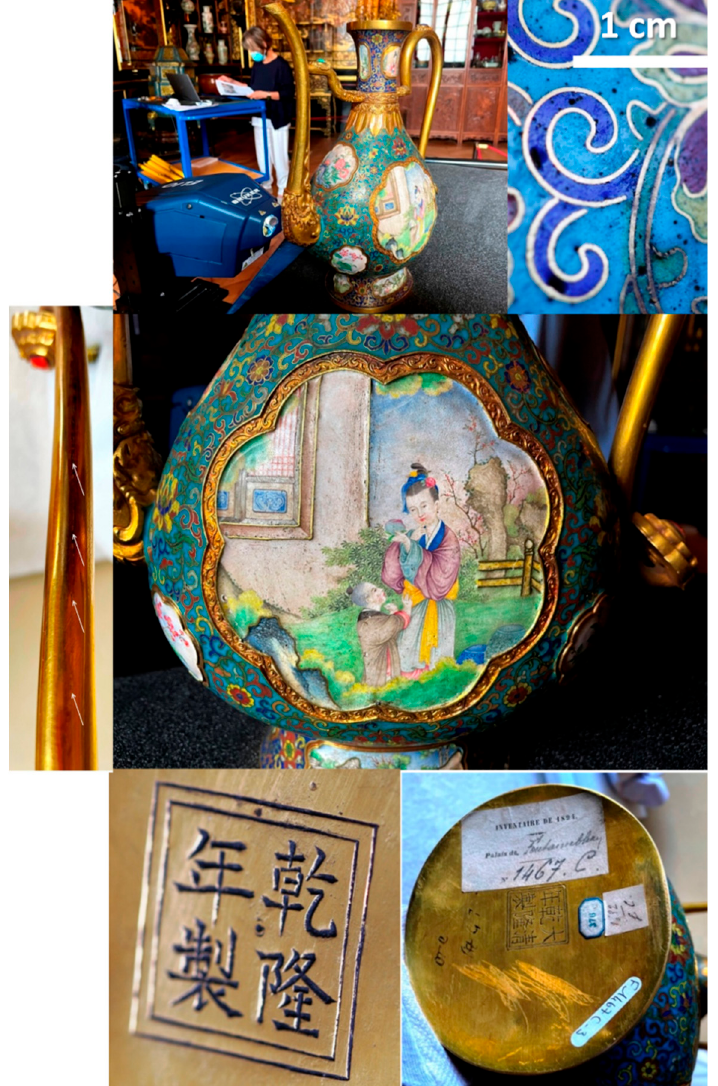
Figure 1. On-site pXRF analysis of the enameled ewer (F1467C) and details of the décor ( cloisonné and painted enamels); the bottom face exhibits an engraved Qianlong reign mark (bottom left, basin: Qian long nian zhi ; right, ewer; Da qing Qian long nian zhi ). Note the welding traces along the spout (arrows).